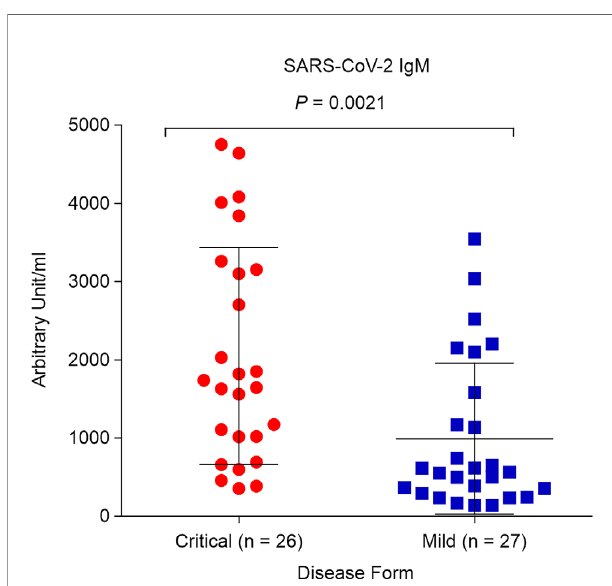
FIGURE 3 | Levels of SARS-CoV-2 immunoglobulin M (IgM) in critical and mild COVID-19 patients ( P = 0.002). ELISA assay was used to detect antibodies against spike and nucleocapsid